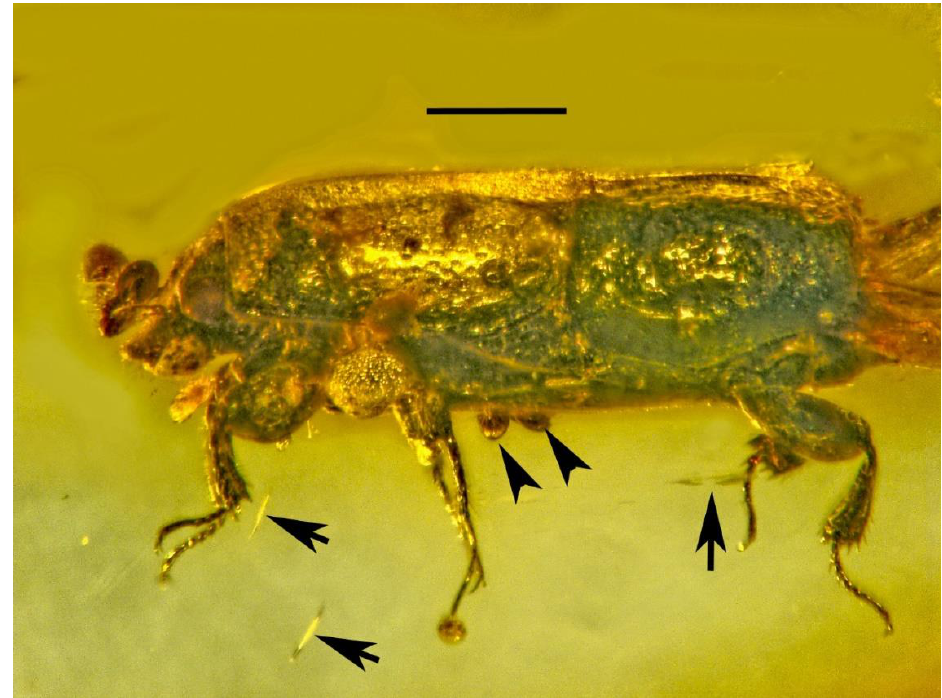
Figure 2. Two mites (Arachnida: Acari) (arrowheads) attached to the underparts of a histerid (Coleoptera: Histeridae) beetle in Dominican amber. Note also associated nematodes (arrows). Scale bar = 580 µm.